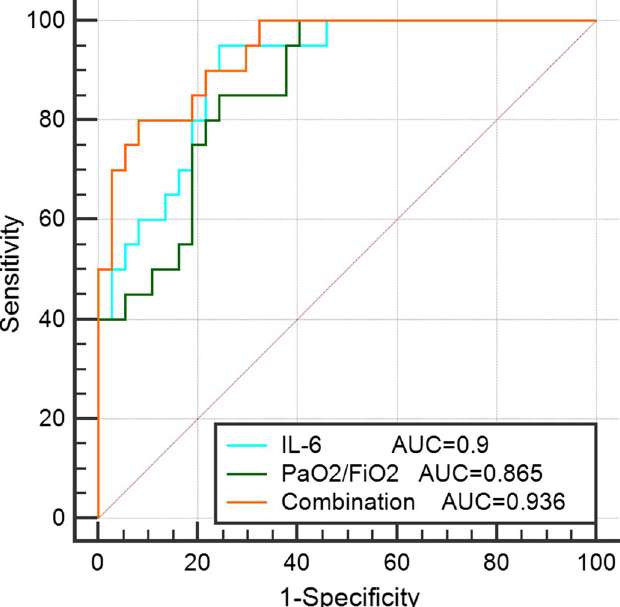
Figure 2. The AUC of IL-6 and PaO2/FiO2 and their combination in patients tested for IL-6. The AUC of IL-6 and PaO2/FiO2 were 0.9 (95% CI: 0.791–0.964, p < 0.0001) and 0.865 (95% CI: 0.748–0.941, p < 0.0001) respectively. The combination ROC curve of IL-6 and PaO2/FiO2 had an AUC of 0.936 (95%CI: 0.839–0.984), which were not statistically significant when compared with IL-6 ( p = 0.319) or PaO2/FiO2 ( p = 0.0502). Abbreviations: AUC: area under the curve; PaO2/FiO2: oxygenation index; IL-6: